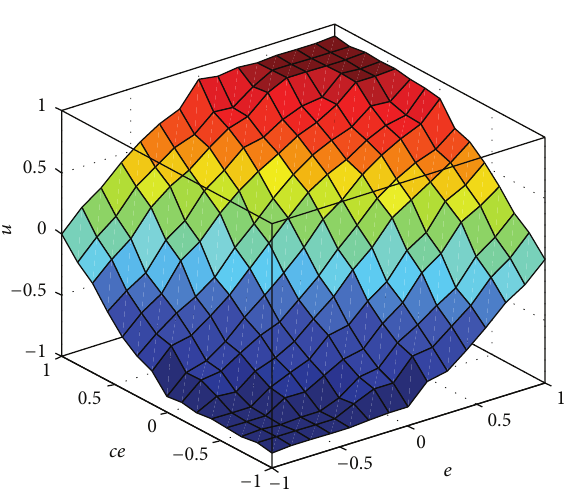
Figure 7: Surface viewer of fuzzy-PID controller for BLDC